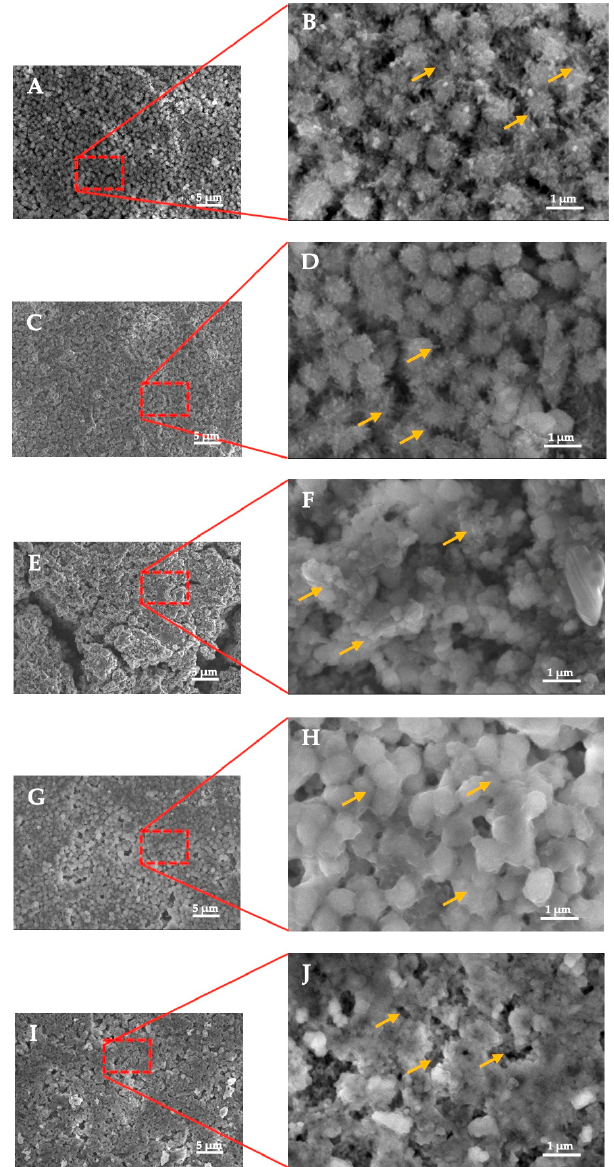
Figure 2. ( A , B ) control specimen; ( C , D ) 1-day exposure to SBF; ( E , F ) 7 days exposure to SBF; ( G , H ) 14 days exposure to SBF; ( I , J ) 21 days exposure to SBF. Noted: The red rectangle is the location of image magnification; the yellow arrow indicates the apatite crystal’s growth and the apparent interface of the apatite layer.